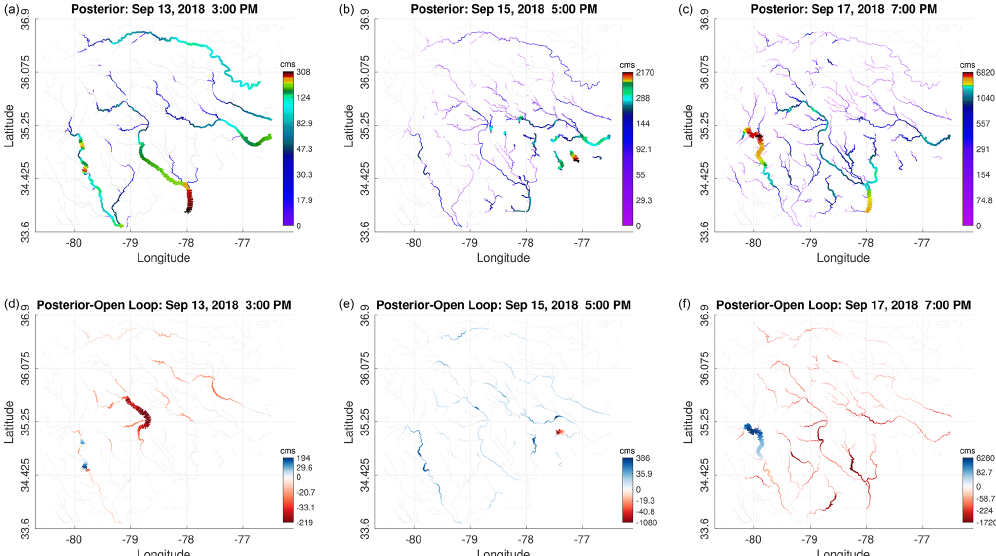
Figure 11. (a, b, c) Posterior streamflow ensemble mean maps resulting from a PP-inf run on 13 September at 15:00UTC (universal coordinated time) (a, d) , 15 September at 17:00 (b, e) , and 17 September at 19:00 (c, f) . (d, e, f) Similar maps but for the difference between the posterior means and the open-loop estimates. Reaches with 0cms flow are shown in gray. Color (log scale) and line thickness both indicate the magnitude